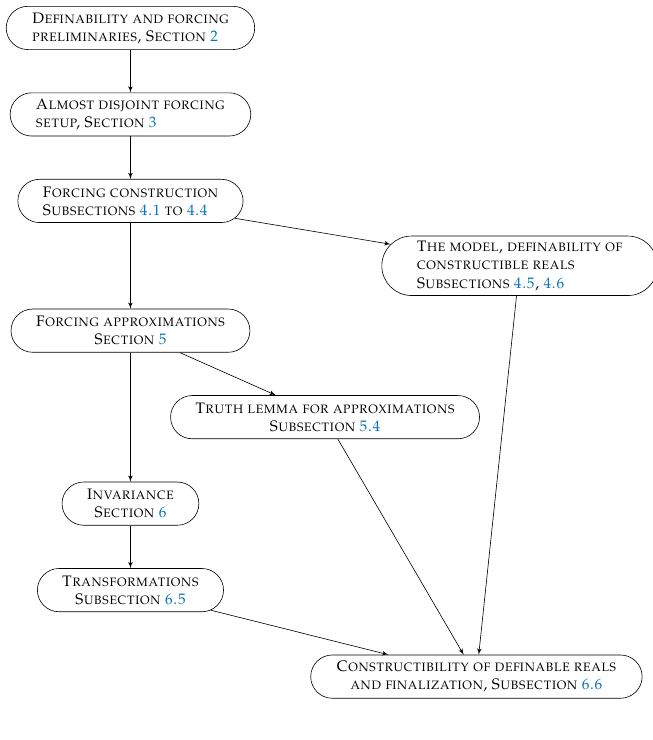
Figure 1. Flowchart of the proof of Theorem